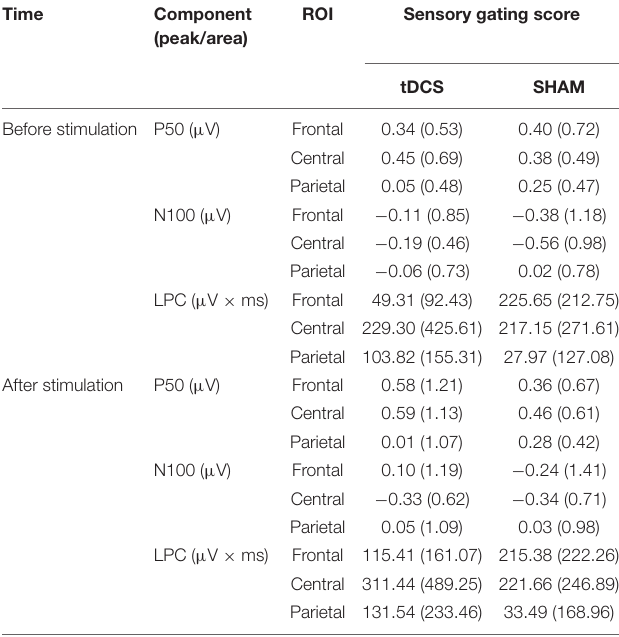
TABLE 3 | Mean ( ± SD) of the sensory gating scores (S1 minus S2) in the tDCS and SHAM group, before and after stimulation. Time Component